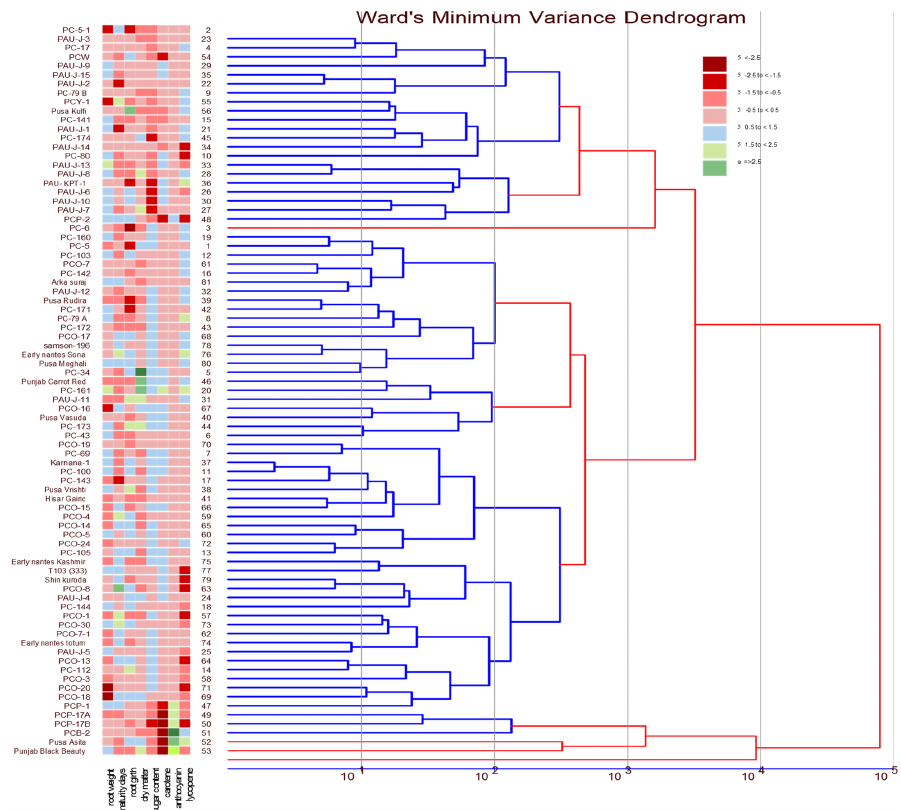
Figure 1. Wards’ Minimum Variance Dendrogram (Euclidian’s method) showing similarity coeffi ‐ cient and the genetic relationship between these 81 carrot genotypes forming ten